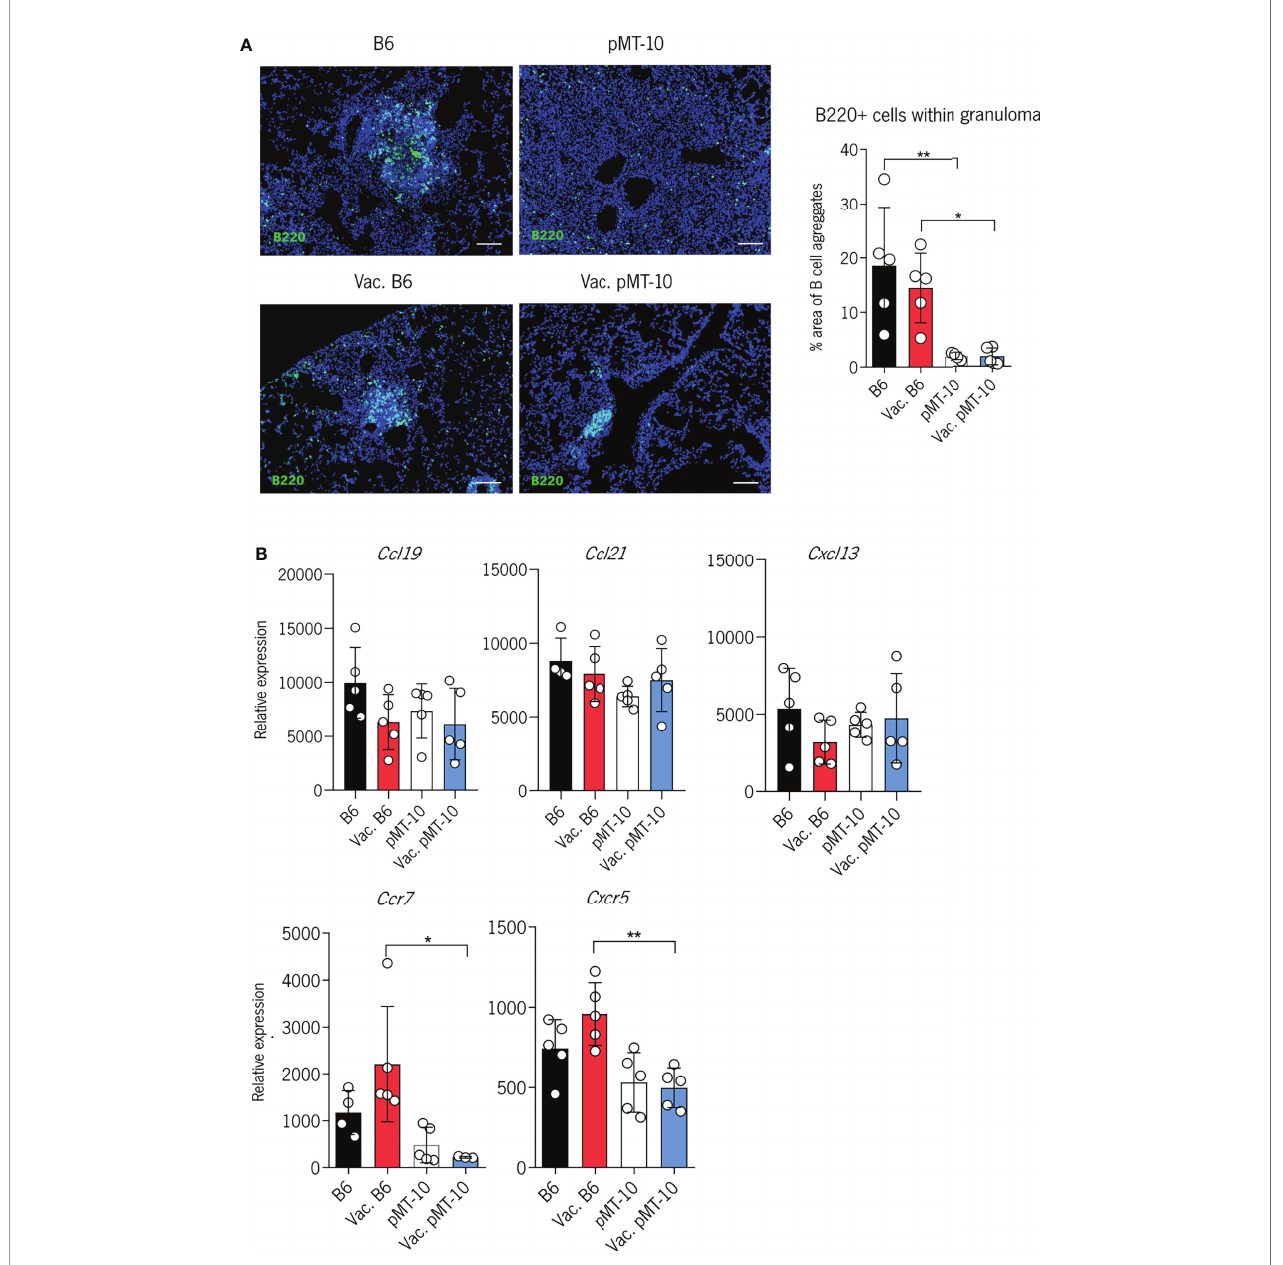
FIGURE 4 | IL-10 overexpression impairs the development of B-cell follicles in the lungs of Mtb-infected mice. B6 and pMT-10 mice were vaccinated with 1 × 10 6 BCG, and control mice were left unvaccinated. Two months after vaccination, mice were infected with Mtb H37Rv via the aerosol route and IL-10 overexpression was initiated. (A) Representative immuno fl uorescence of B220 + cells in the lungs of mice and frequency of granuloma area with B-cell aggregates at day 40 after Mtb infection. (B) Relative expression of homeostatic chemokines and chemokine receptors with critical roles in the formation of B-cell follicles following Mtb infection. Scale bar: 100 µm. Data represent one experiment out of two independent experiments performed, each with four to fi ve mice per group. *P < 0.05, **P < 0.01 by one-way ANOVA followed by Tukey ’ s